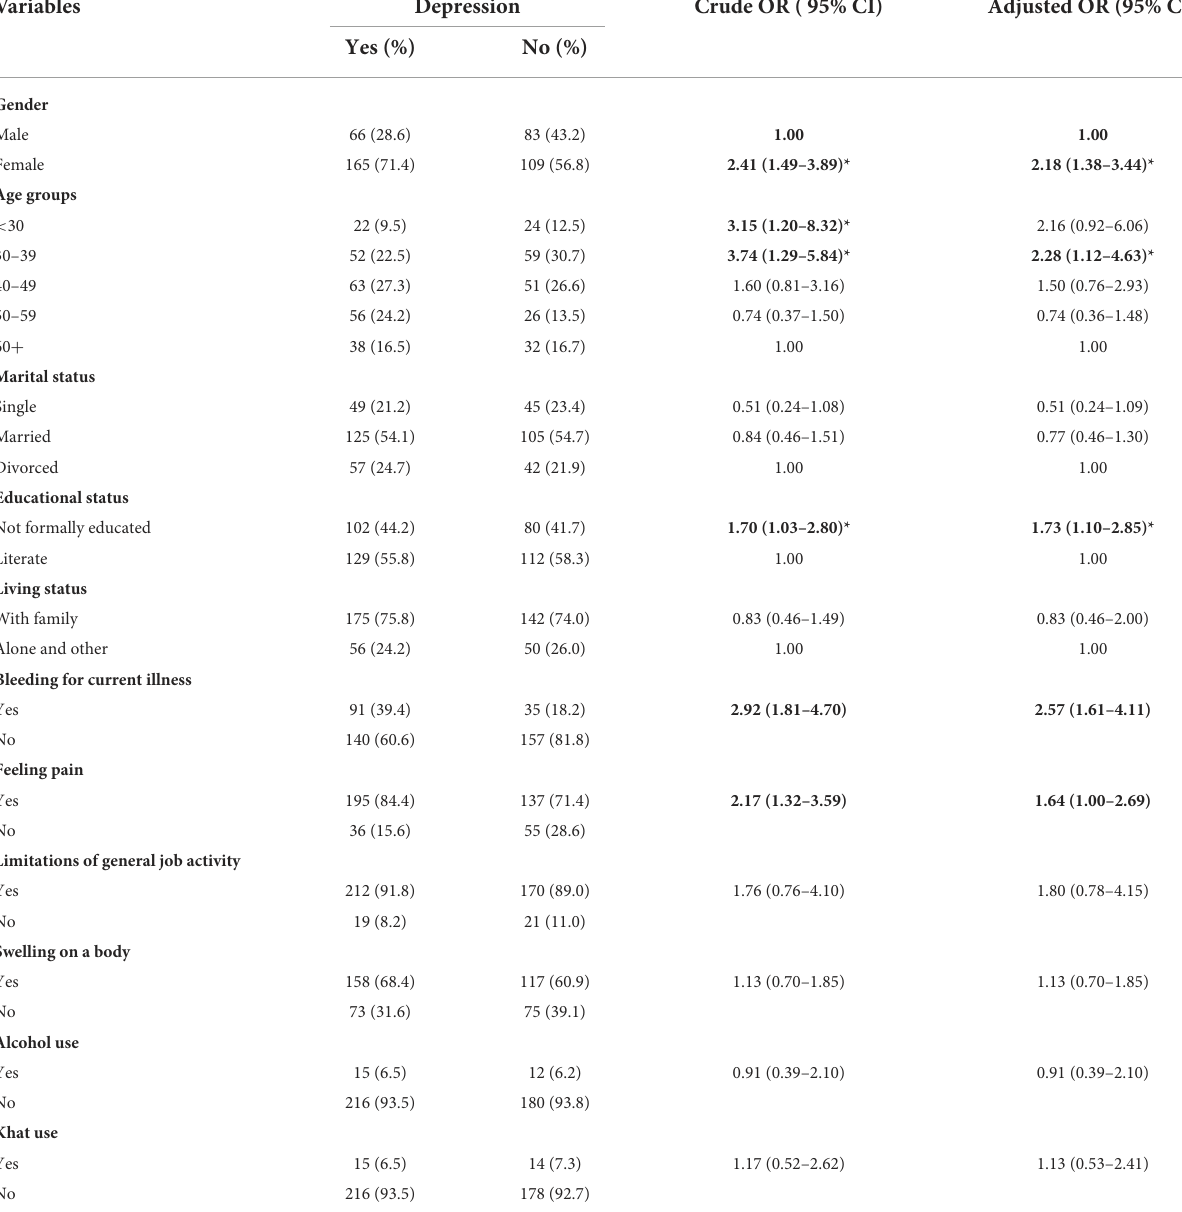
TABLE 2 Bivariate and Multivariate logistic analysis result of depression study subjects among adult patients attending Oncology clinic at Tikur Anbessa Hospital, Addis Ababa, Ethiopia, 2018. Variables Depression Crude OR ( 95% CI) Adjusted OR (95%